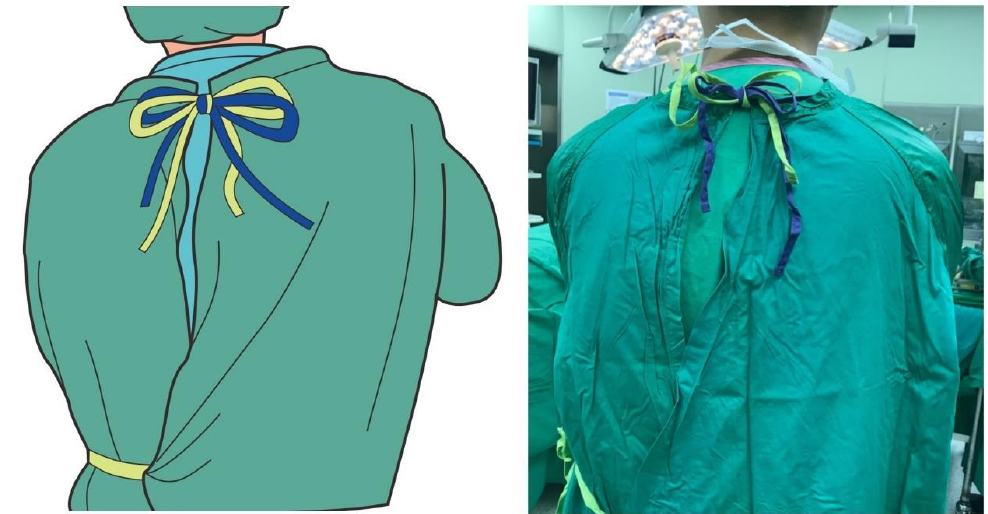
Figure 2. Illustration of the combined tie-fastening method for two sets of rear neck ties.